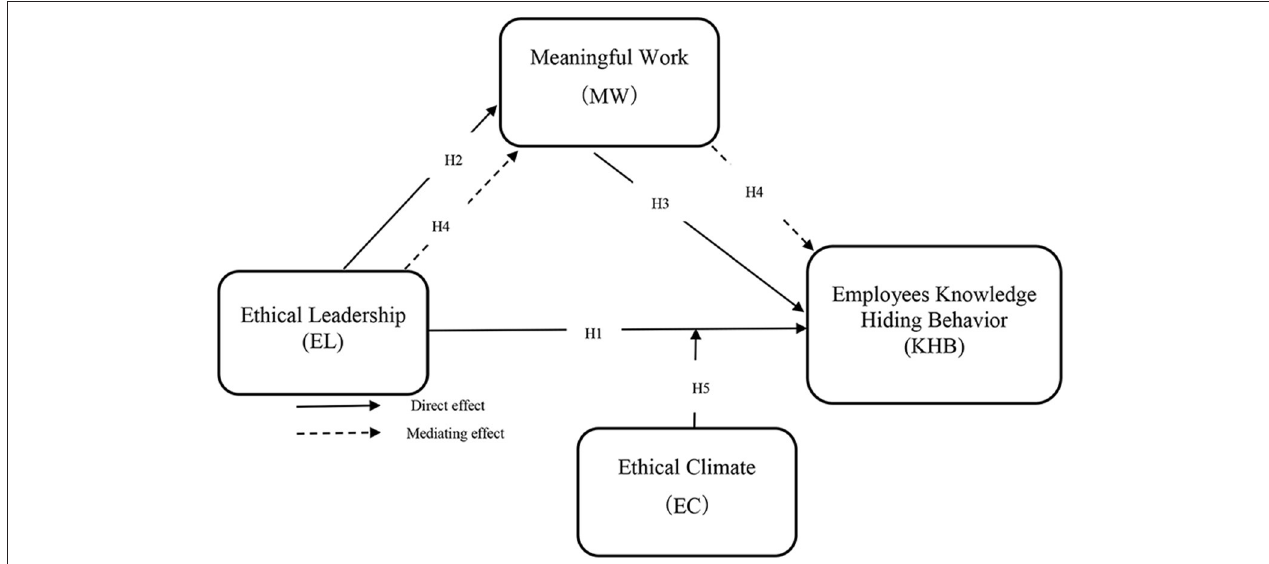
FIGURE 1 | Conceptual